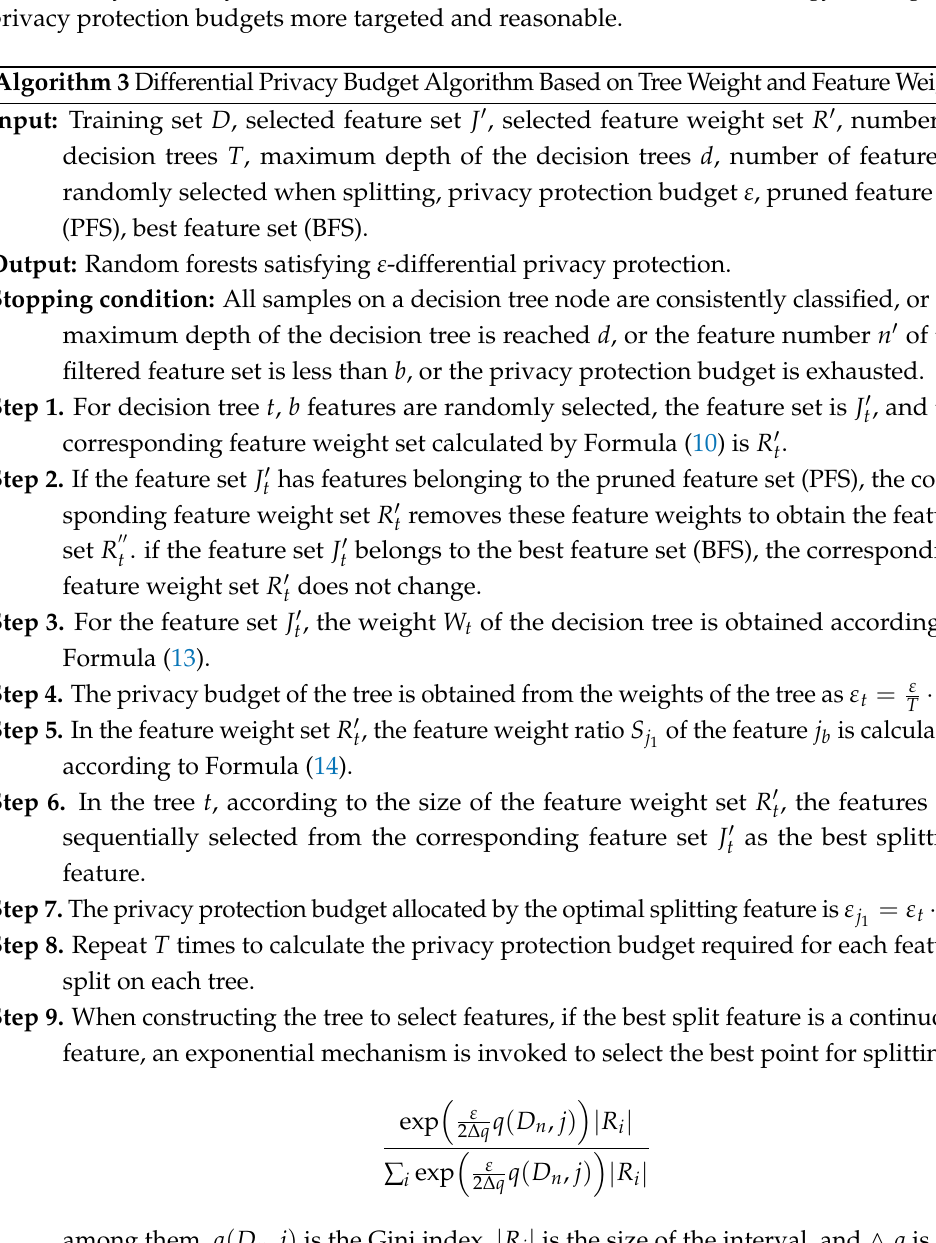
Algorithm 3 is a differential privacy budget allocation algorithm based on tree weights and feature weights. The tree weight calculation, pruning and differential privacy budget allocation by randomly selected features in the construction makes the strategy of assigning privacy protection budgets more targeted and reasonable. Algorithm 3 Differential Privacy Budget Algorithm Based on Tree Weight and Feature